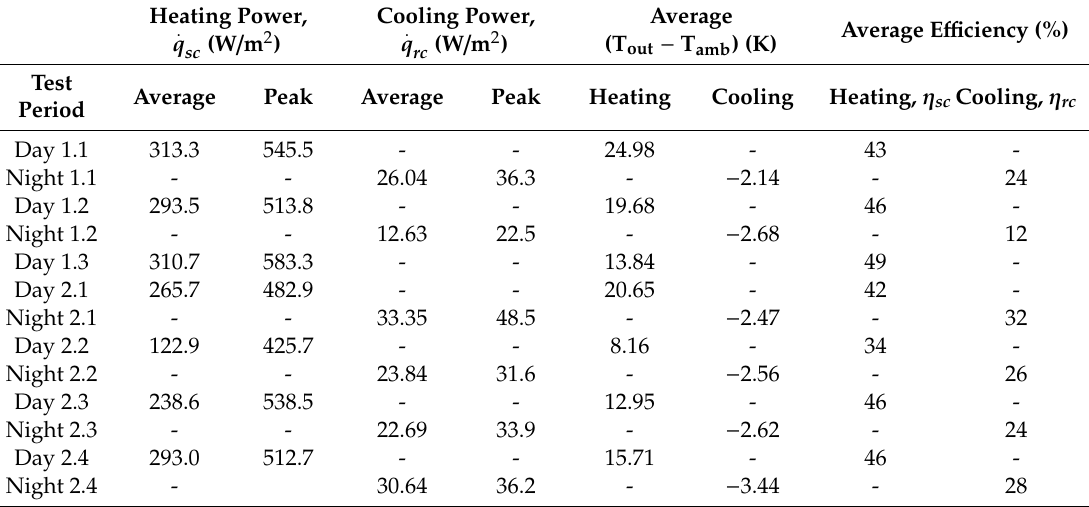
Figure 4. Available heating and cooling power from the RCE concept. Table 3. Average and peak power produced, average temperature diffrence and average efficiency by the RCE for both heat and cold production.